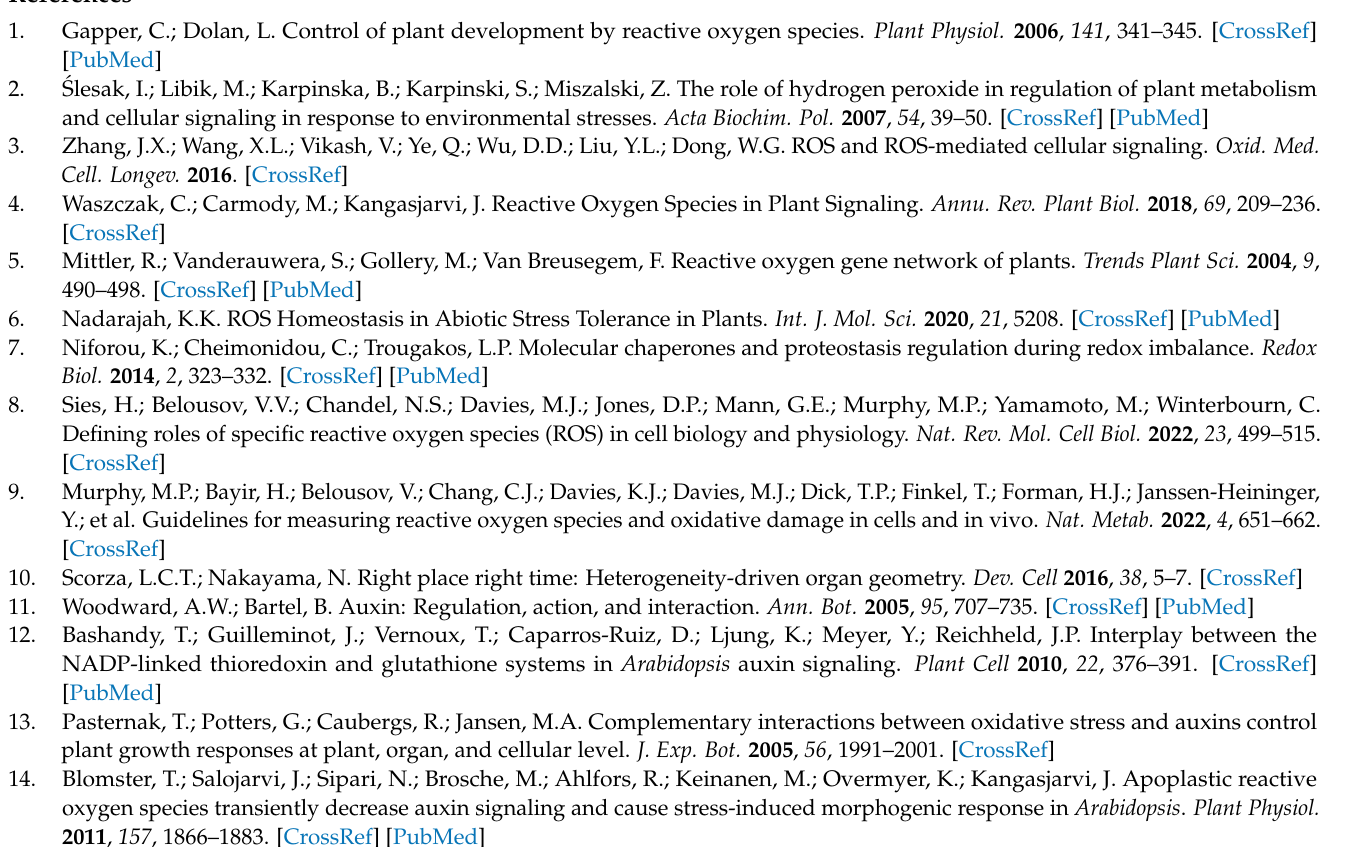
exogenous redox reagents on the expression of PIN genes in mtHSC70-1 mutant and WT seedlings by Q-PCR. Figure S4. Effects of exogenous redox reagents on PIN protein levels in mthsc70-1a / PIN-GFP and Col/ PIN-GFP root tips. Figure S5. Effects of exogenous redox reagents on the auxin response. Table S1. List of primers used in this study. Table S2. Genotypes of the transgenic lines used in this